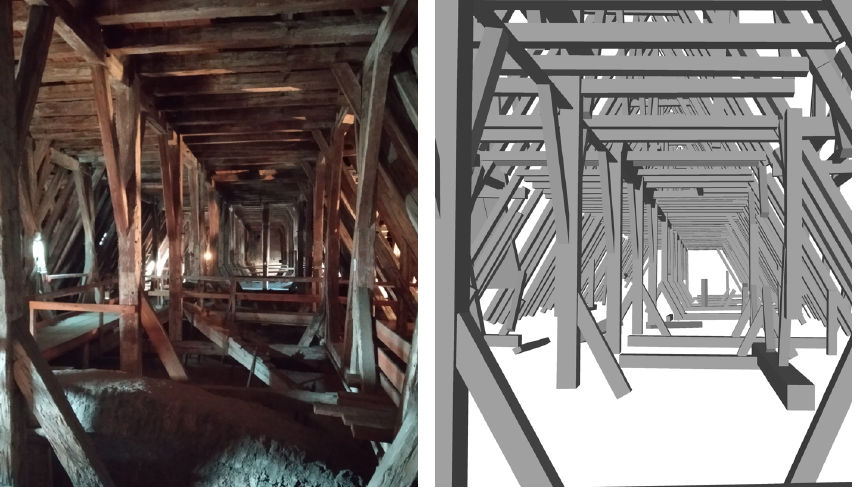
Figure 13. Roof interior image ( left ) and cuboid modeling result of Method 2 ( right